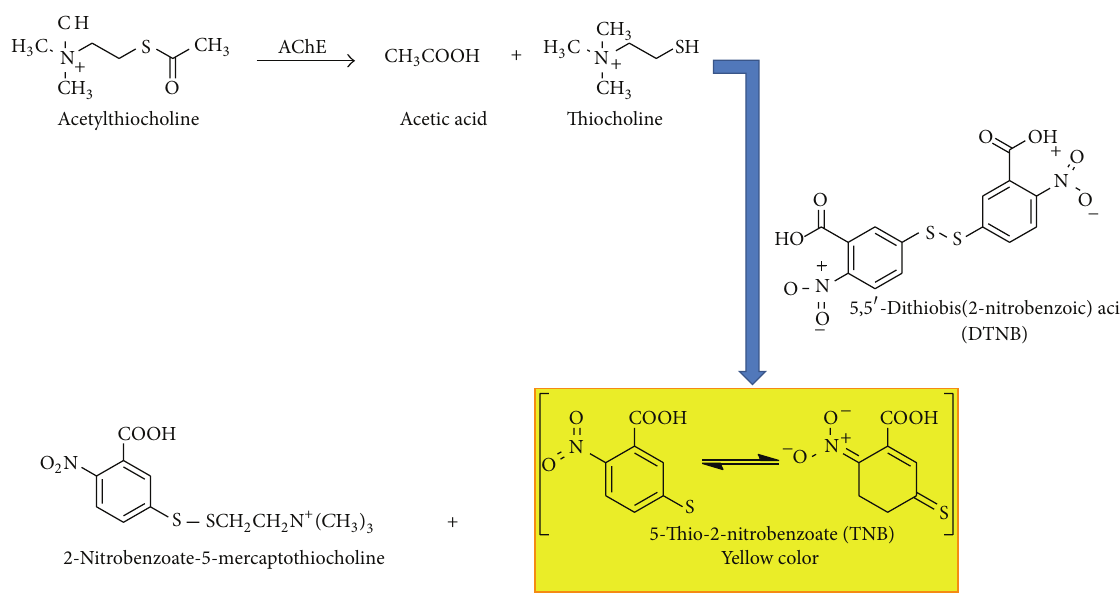
Figure 2: Acetylcholinesterase (AChE) hydrolyzes the acetylthiocholine and forms thiocholine base, which then reacts with dithiobisni- trobenzoate (DTNB) to generate 5-thio-2-nitrobenzoate (TNB, an anion), which is yellow in color.